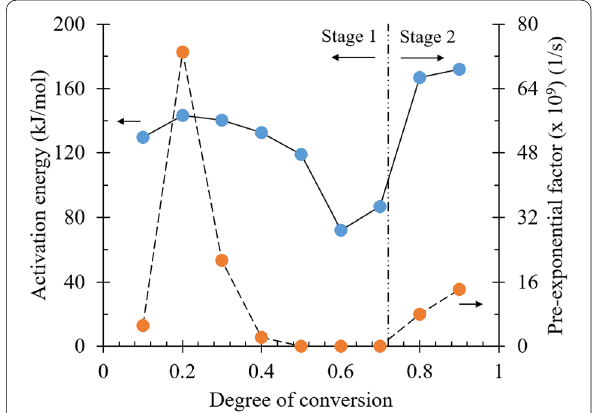
Fig. 6 Apparent activation energy and pre-exponential factor as a function of conversion degree calculated by Friedman method